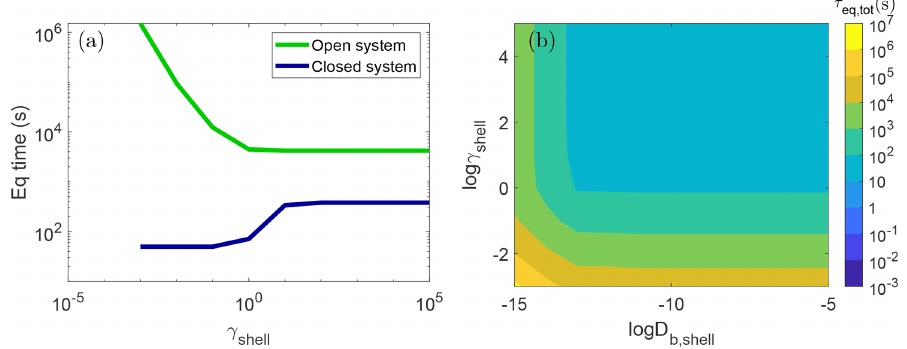
Figure 5. (a) Equilibrium timescale of SOA partitioning ( τ eq , tot ) with a particle with bulk diffusivity in the shell of D b , shell = 10 − 15 cm 2 s − 1 and varying activity coefficients of the condensing species. The green and blue lines show the simulations in the open and closed system, respectively. (b) τ eq , tot as a function of the activity coefficient of the condensing species ( γ shell ) and bulk diffusivity ( D b , shell ) in the shell in the open system. Due to computational limitations, simulations using slower diffusivities than D b , shell = 10 − 15 cm 2 s − 1 were not